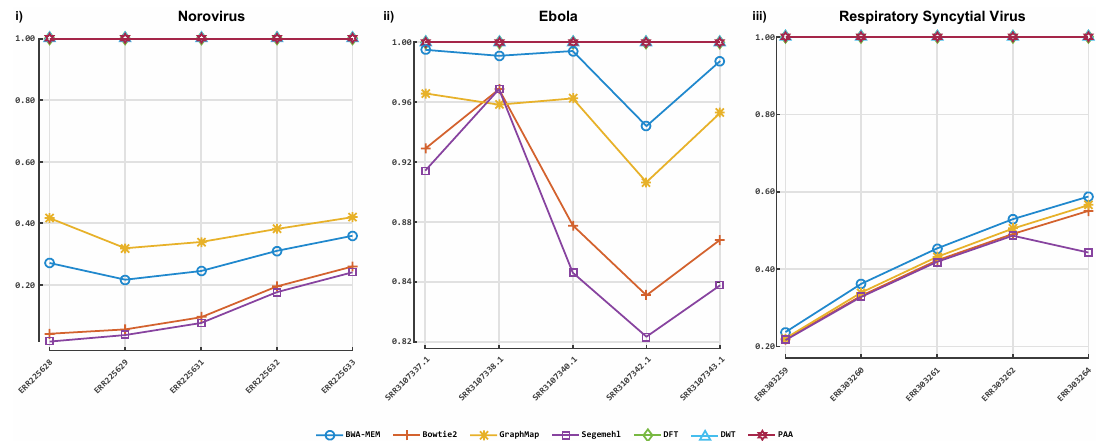
Figure 8. Accuracy of our prototype aligner implementation and four established tools on mixed viruses simulated datasets. The y -axis indicates the F -measure score, and the x -axis depicts the reads data files. The plot depicts the F -measures obtained for each aligner on the mixed virus simulations. DFT: discrete Fourier transform; DWT: discrete wavelet transform; PAA: piece-wise aggregate approximation.